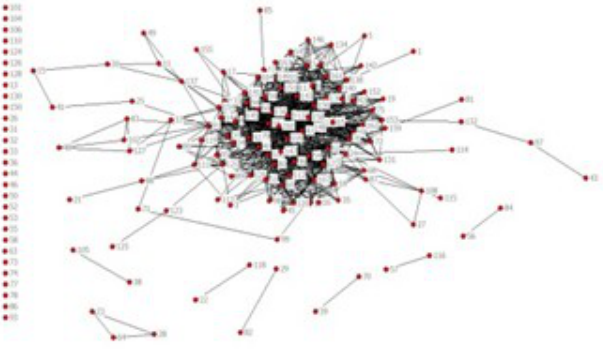
Figure 5. The SSE 180-Index Sample Stock Network Topology with Threshold